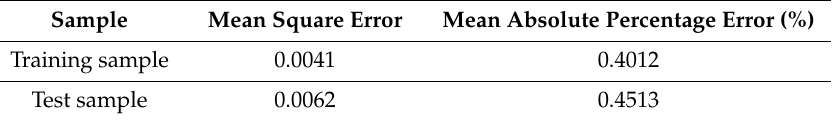
Table 4. BP neural network performance evaluation results (10 random times).